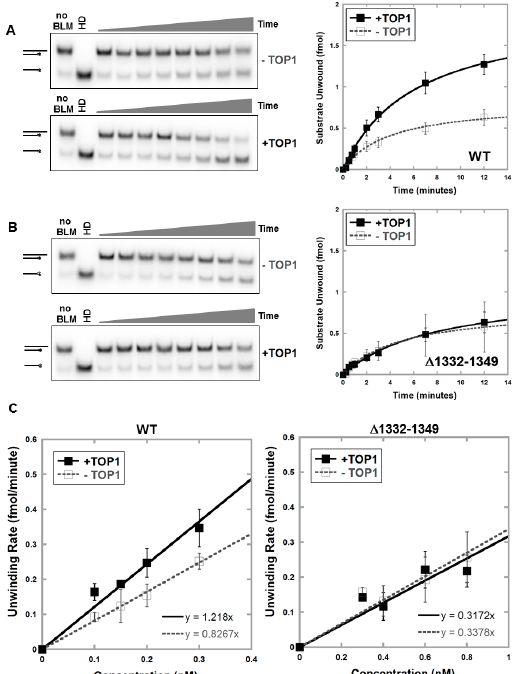
Figure 2. Unwinding of RNA:DNA substrate by BLM- ∆ 1332–1349 is not stimulated by TOP1. Kinetics of unwinding of RNA:DNA substrate was assessed using a range of BLM protein concentrations with and without TOP1. Representative gels and kinetics of unwinding for one representative protein concentration, 0.2 nM BLM-WT ( A ) or 0.3 nM BLM- ∆ 1332–1349 ( B ) are shown. BLM protein with two-fold molar excess TOP1 or equivalent volume of reaction buffer was incubated with 2 fmol RNA:DNA substrate for 0.25, 0.5, 0.75, 1, 2, 3, 7 and 12 min at 37 °C, and double ‐ and single ‐ stranded products were separated on non ‐ denaturing acrylamide gels. Heat denatured (HD) substrate was generated by heating at 95 °C for 5 min. Unwinding was quantified as the amount of single ‐ stranded substrate generated compared to the total substrate per time ‐ point. Experiments were repeated 3 to 6 times for each protein concentration, and curves showing amount the Michaelis ‐ Menten equation. Reactions with TOP1 alone were performed with each experiment